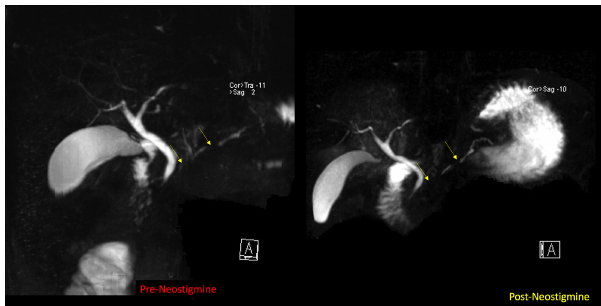
Figure 4. MRCP in a 21-year-old female patient, with a history of recurrent acute pancreatitis. In coronal cholangiographic sequences, there are probable foci of segmental stenosis of the Wirsung (yellow arrows) which do not distend after Neostigmine ® administration and become more evident. Note the slight but more pronounced upstream dilatation. The diagnosis of the suspected autoimmune pancreatitis was subsequently confirmed by contrasted images, serology, and response to steroid